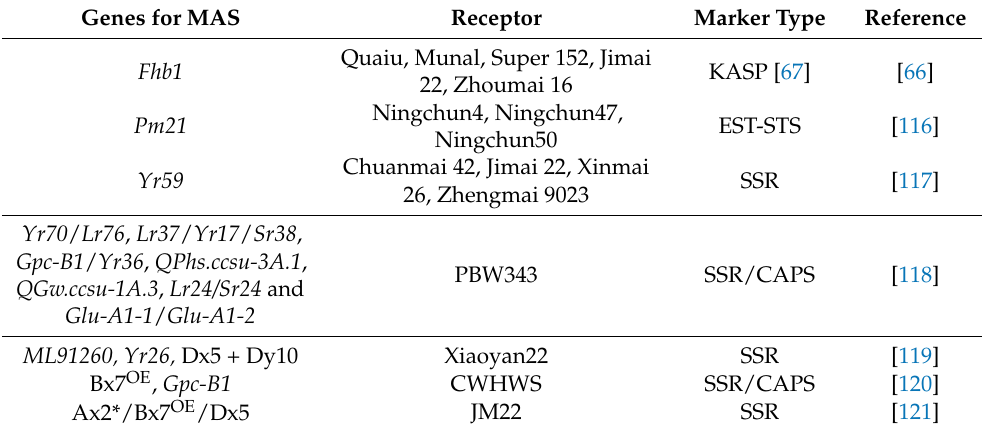
Table 2. Examples of using MAS stacking some key genes. Genes for MAS Receptor Marker